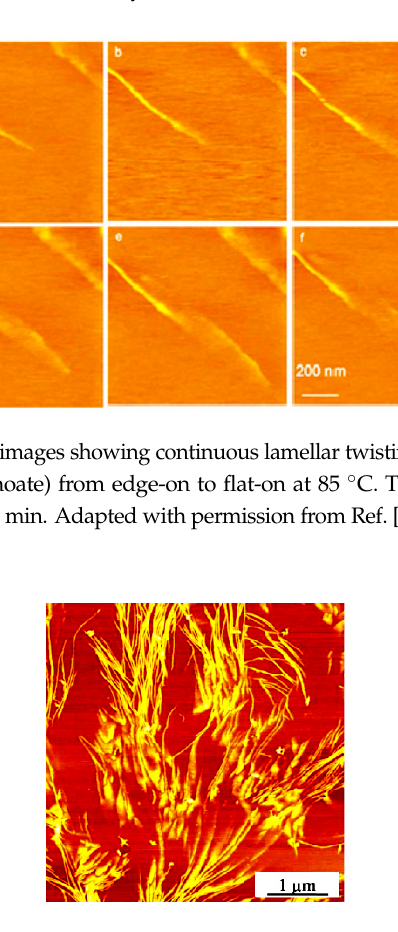
Figure 5. Real-time AFM phase images showing lamellar twisting process of poly( R -3-hydroxybutyrate-co-17 mol% R -3-hydroxyhexanoate) at 75 °C. The images in ( b – f ) correspond to elapsed time of 6, 12, 18, 24, and 36 min, respectively, with respect to the first image ( a ). The arrows labeled with S indicate macro screw dislocations and B points to backward growth. Adapted with permission from Ref. [27]. Copyright (2004) American Chemical Society.